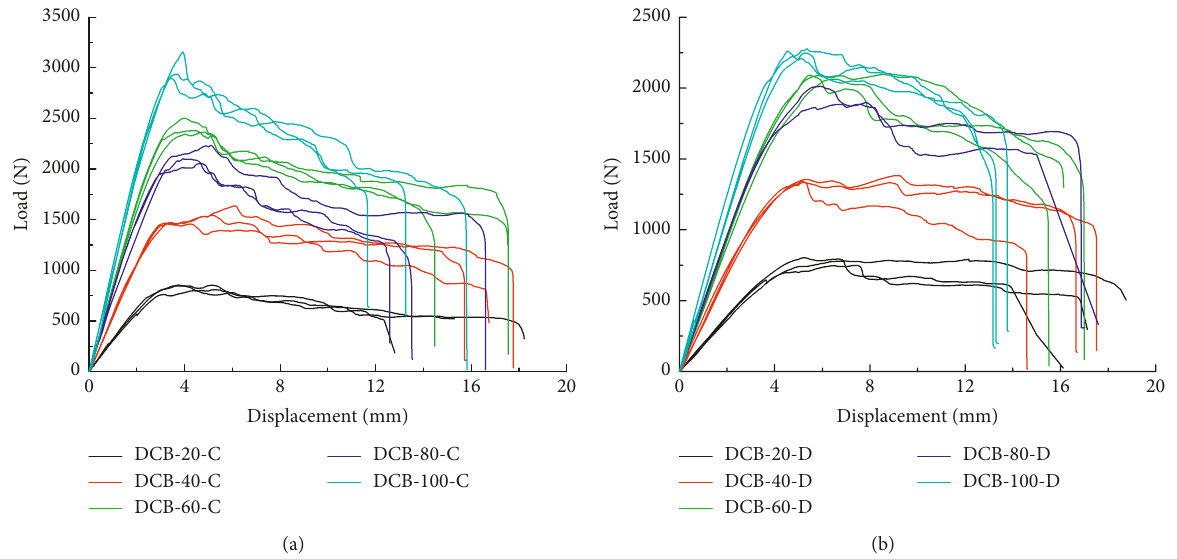
Figure 7: Load-displacement curves of DCB specimens with different widths in the same initial crack length: (a) initial crack length a 0 � 100mm; (b) initial crack length a 0 �